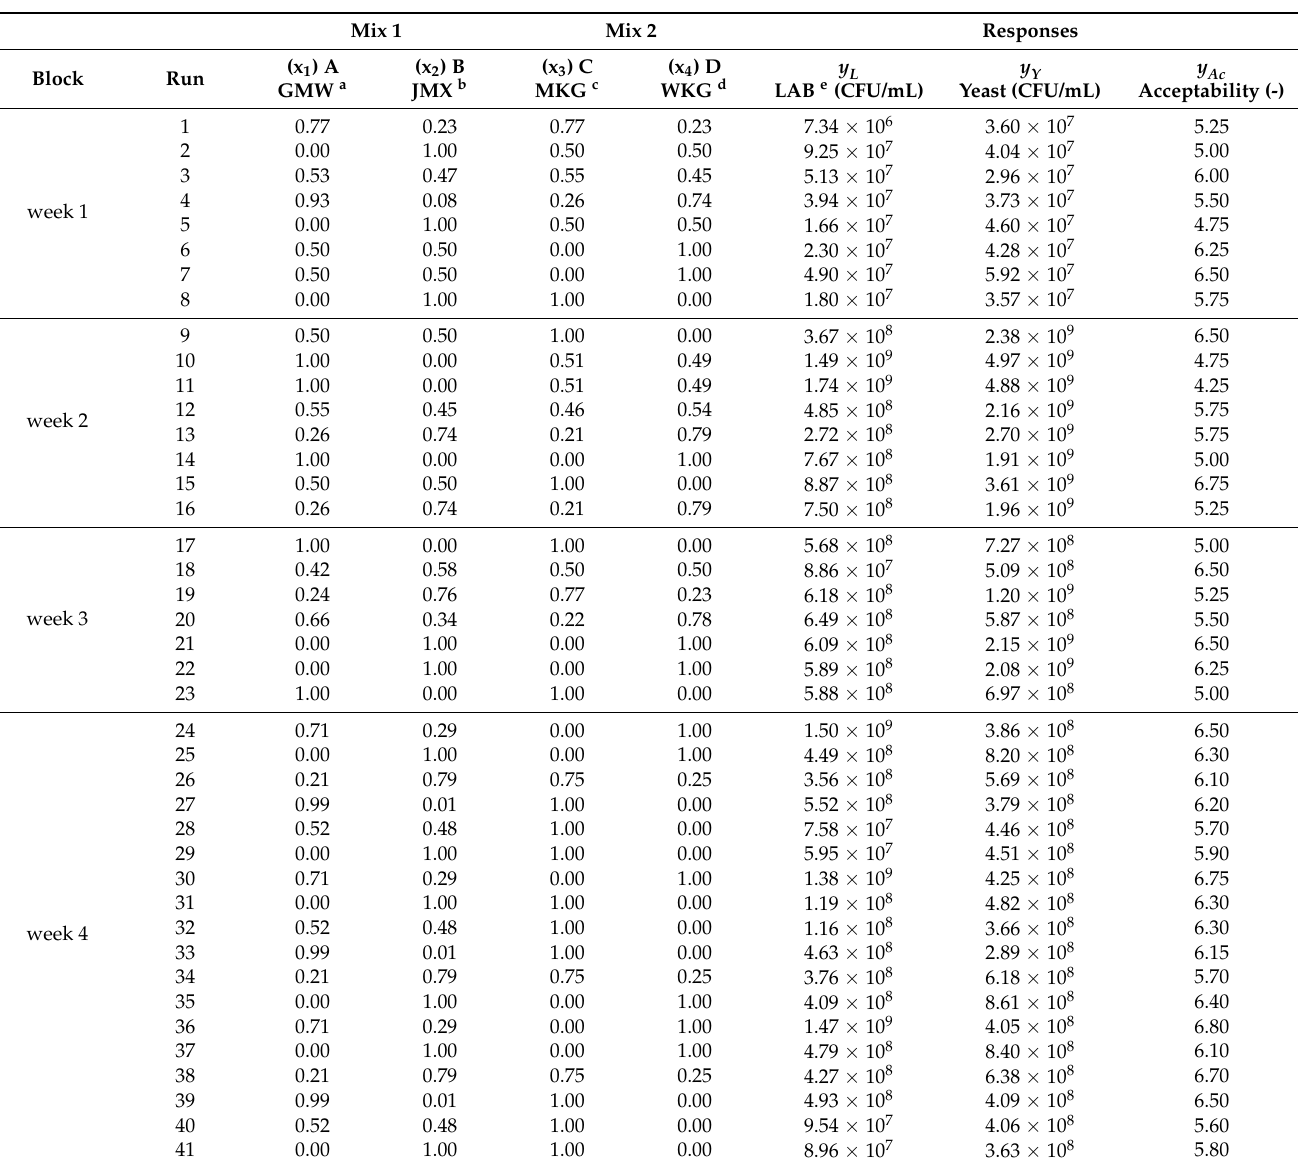
Table 1. Dual mix factors and their responses in the L-optimal Response Surface Methodology. Mix